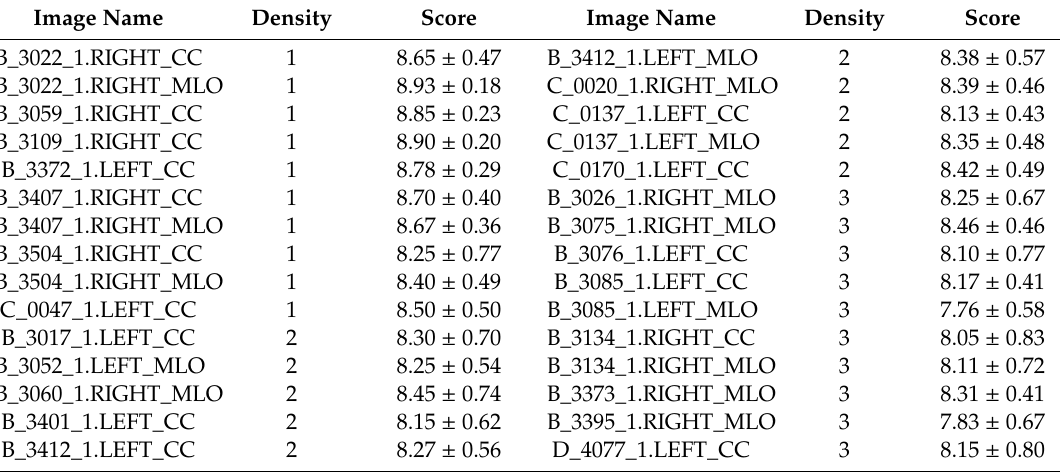
Table 5. Assessment score of the detection results.